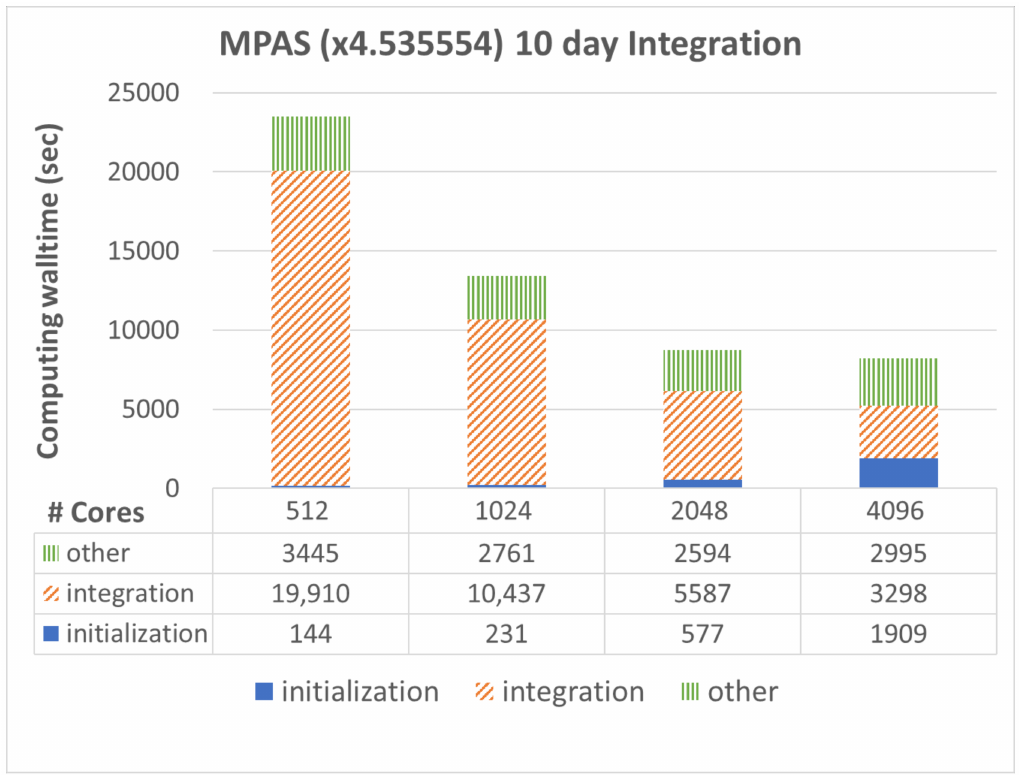
Figure 5. Computational walltime (seconds, y-axis) of 60–15 km MPAS 10 day simulation with various numbers of cores (x-axis) on NURION. Here, the computation of MPAS consists of initialization (blue closed bars on the bottom), time- integration (orange diagonal lined bar in the middle), and other processes (green vertical lined bar on the top). Values for those three processes are provided in a table under the bar